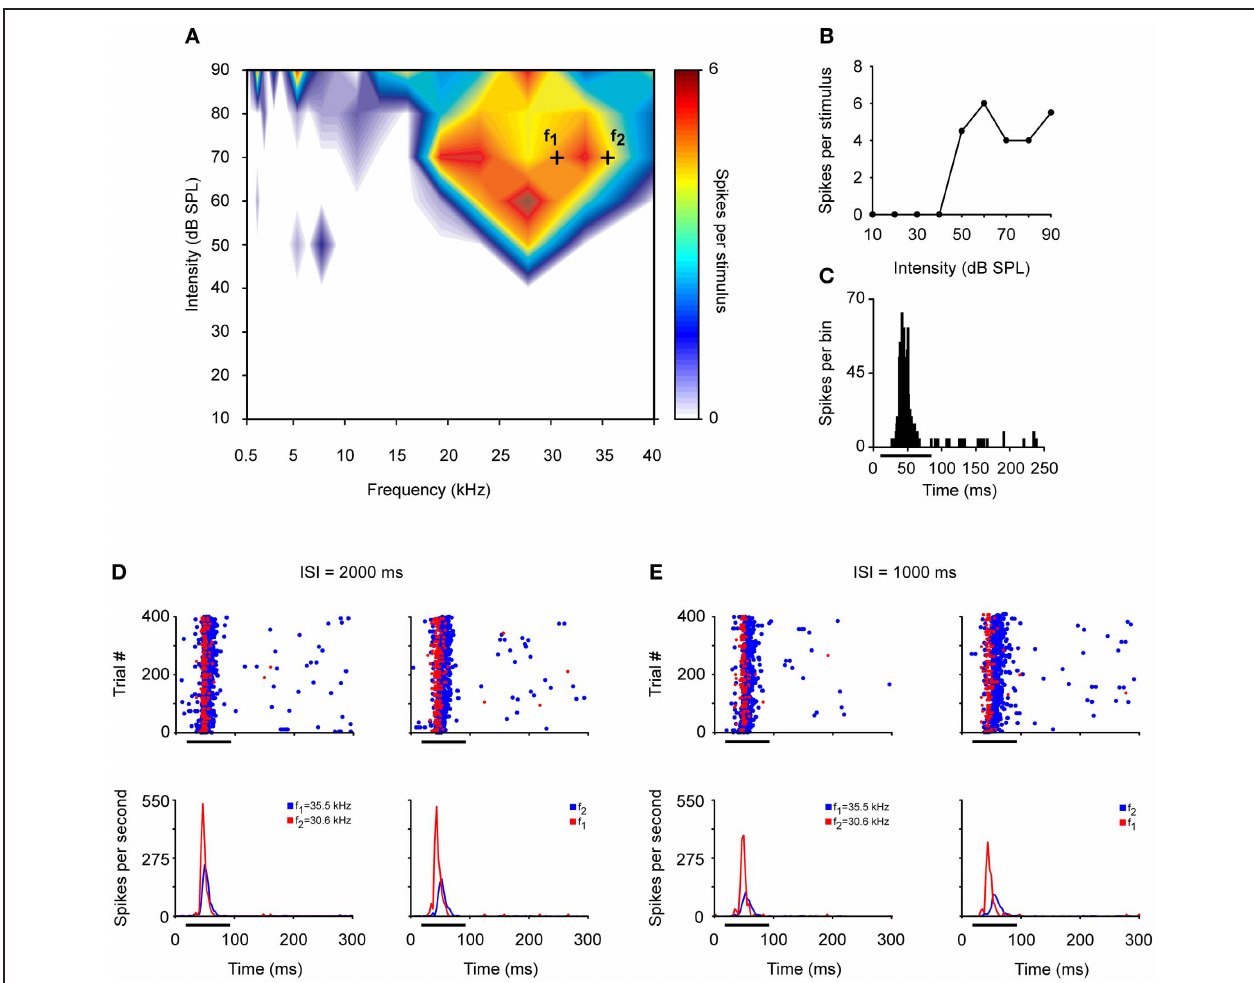
FIGURE 4 | Example of an IC neuron that exhibits SSA at low repetition frequencies. (A) Broad frequency response area displayed in color code according to the strength of the response. Black crosses represent a frequency pair— f 1 (30.6kHz) and f 2 (35.5kHz)—with a physical separation of 0.216 octaves ( (cid:2) f = 0 . 15) at 70dB SPL. (B) The neuron exhibits a non-monotonic rate-level function at its best frequency (27.1kHz). (C) PSTH of the accumulated responses to all the frequencies (0.5–40 kHz) and intensities (10–90dB SPL) presented (1ms bins). (D) Top panels. Dot rasters